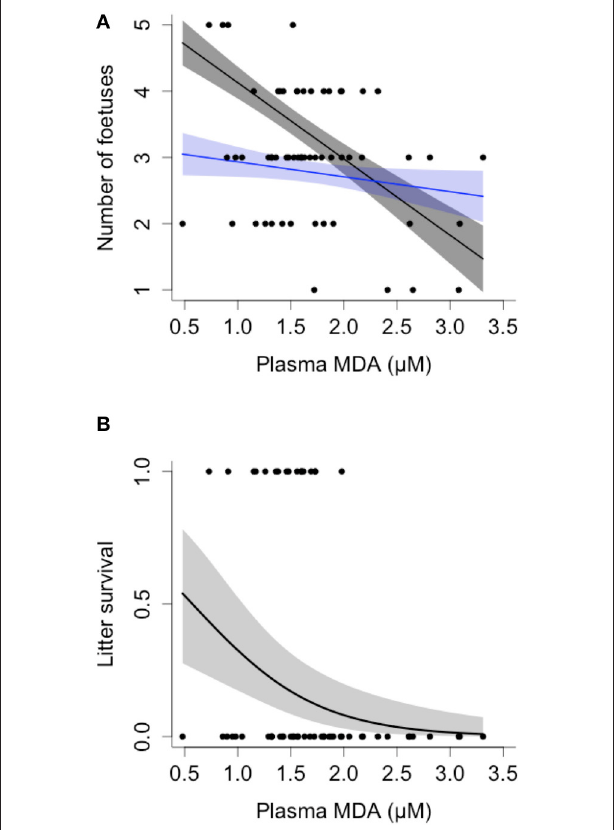
FIGURE 4 | Oxidative damage, fetal litter size, and offspring survival in banded mongooses. (A) Mothers exhibiting higher levels of malondialdehyde (MDA) during gestation carried fewer fetuses, as measured via ultrasound. Oldest females had the steepest decline in fetal litter size; model values are plotted for females at 2 (blue) and 5 years of age (gray) for illustrative purposes. (B) Mothers with higher levels of MDA during gestation had reduced litter survival after taking into account fetal litter size, see text for details of the analysis. Plots show GLMM values ± SE and raw